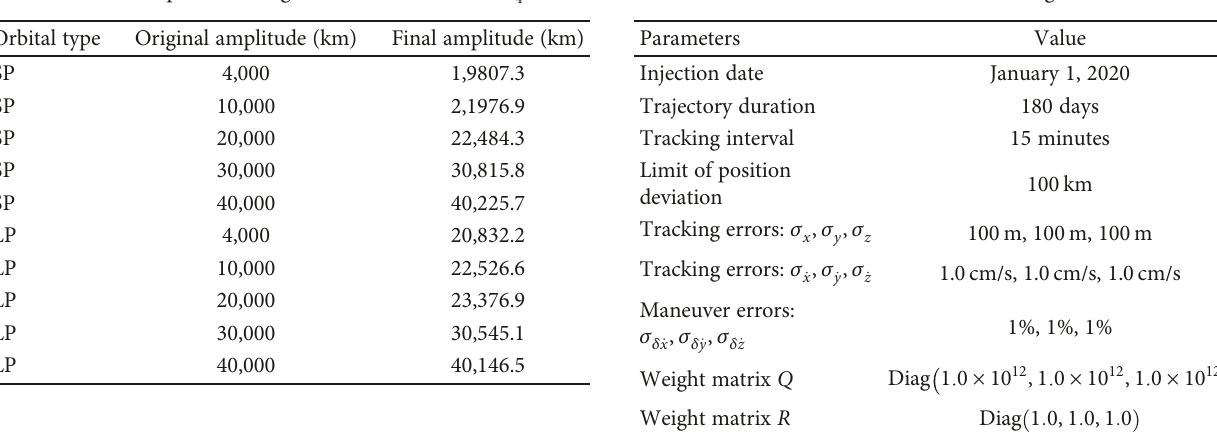
Figure 3: Amplitude enlargement of LP and SP orbits: (a) a SP orbit with initial patch points ( amplitude = 10,000km ) and (b) a LP orbit with initial patch points ( amplitude = 10,000km ). Table 2: Amplitude enlargement of LPOs around L . Table 3: Parameter 4